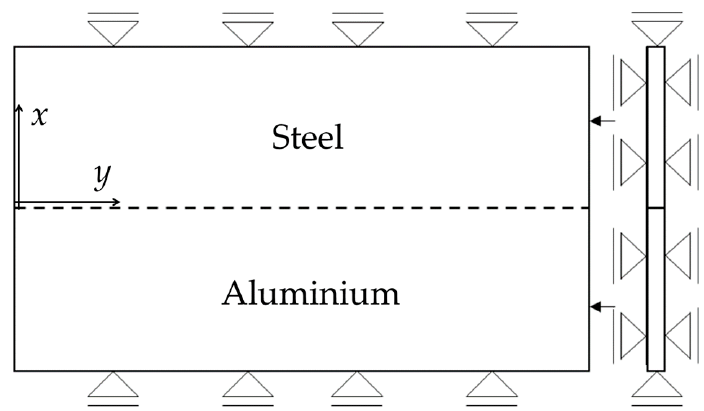
Figure 7. Schematic representation of the welded plates with lateral and out-of-plane constraints (uniformly applied to the top and bottom surfaces of the plates) assumed in the FE model.